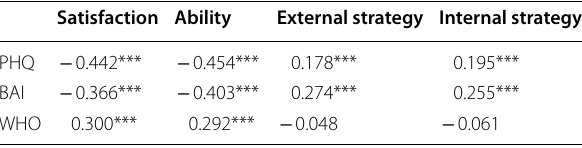
Table 5 Pearson’s correlation coefficients between MMQ